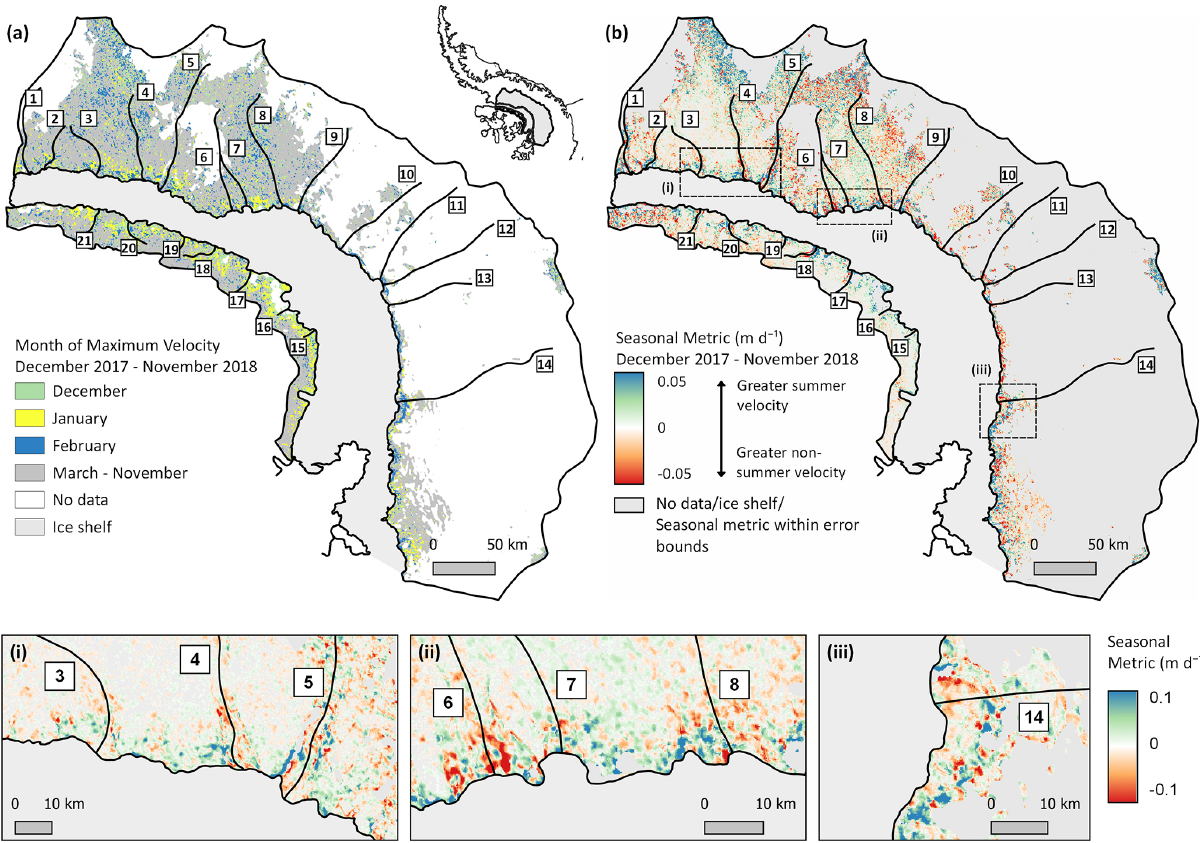
Figure B4. Same as Fig. 3 but showing spatially resolved patterns of seasonal ice flow as observed between December 2017 and Novem- ber 2018. Panel (a) shows the month of maximum velocity ( v time ) and (b) the calculated velocity anomaly ( v anom velocity anomalies (blue) indicate summertime speed-up and negative (red) greater velocity during non-summertime months. Dashed boxes denote the location of the inset boxes (i–iii). See also Figs.